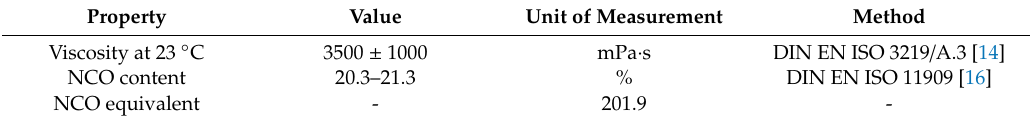
Table 2. Physical and chemical properties of polyisocyanate Bayhydur XP